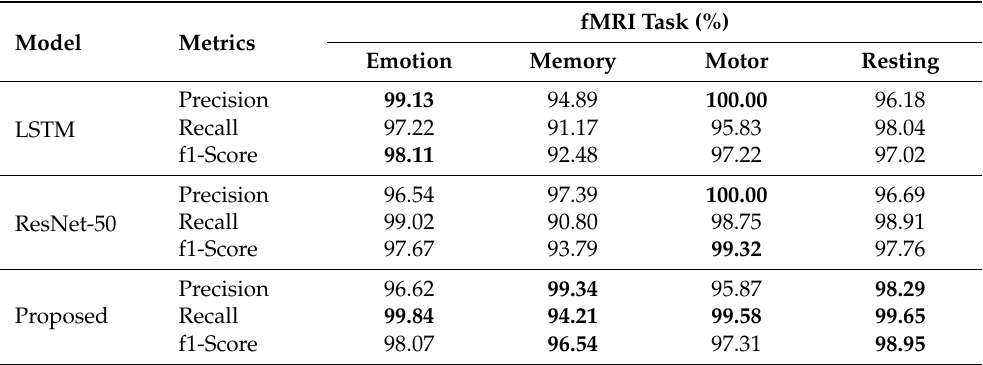
Table 2. Classification performances of models for behavioral, cognitive, and affective tasks classifica- tion